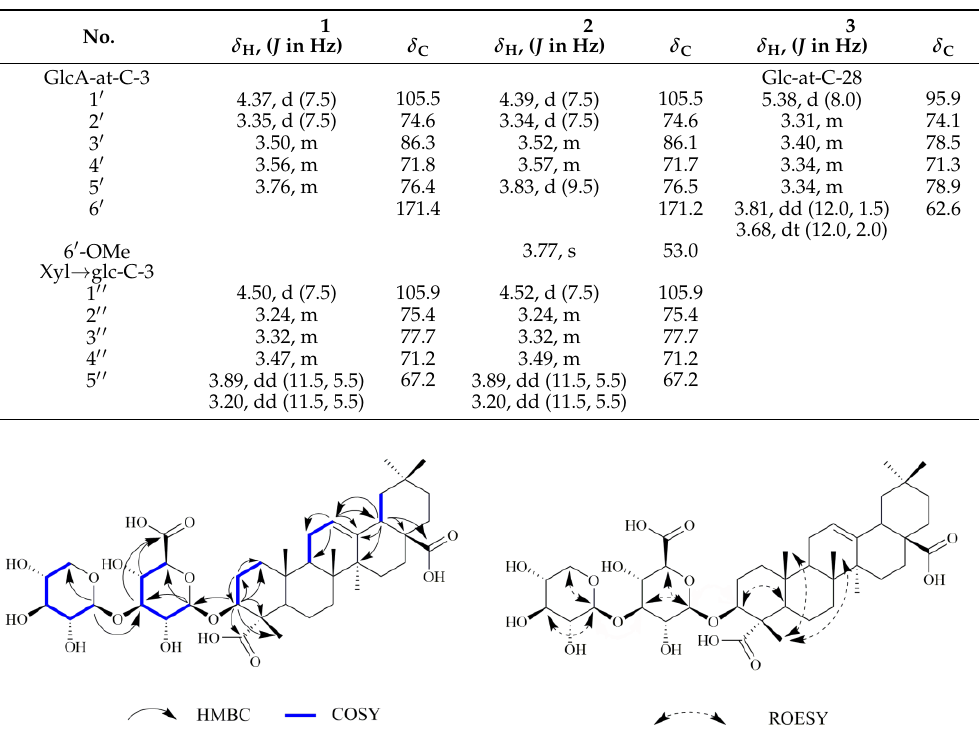
Table 2. 1 H NMR (500 MHz) and 13 C NMR (125 MHz) data of the sugar moieties for compounds 1 – 3 in methanol- d 4 .